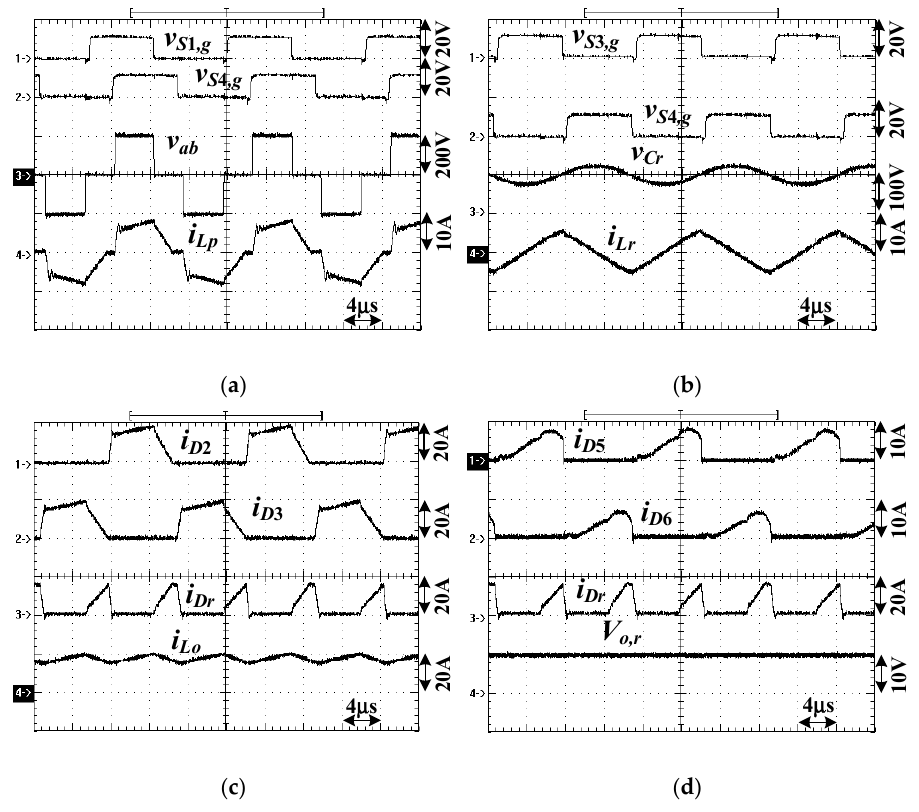
Figure 8. Measured results at V in = 190 V and full load under high voltage input region ( a ) v S 1 ,g , v S 4 ,g , v ab , and i Lp ( b ) v S 3 ,g , v S 4 ,g , v Cr , and i Lr ( c ) i D 2 , i D 3 , i Dr , and i Lo ( d ) i D 5 , i D 6 , i Dr , and V o,r .